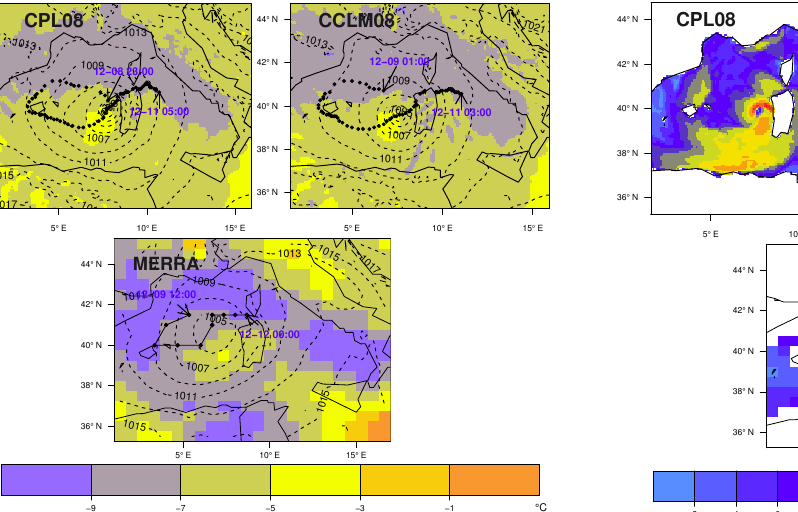
Figure 9. ME09; 10m wind speed (ms − 1 ) in the coupled and atmosphere-only (0 . 08 ◦ ) simulations and the NOAA “Blended Sea Winds” on 10 December 1996 at 18:00UTC.